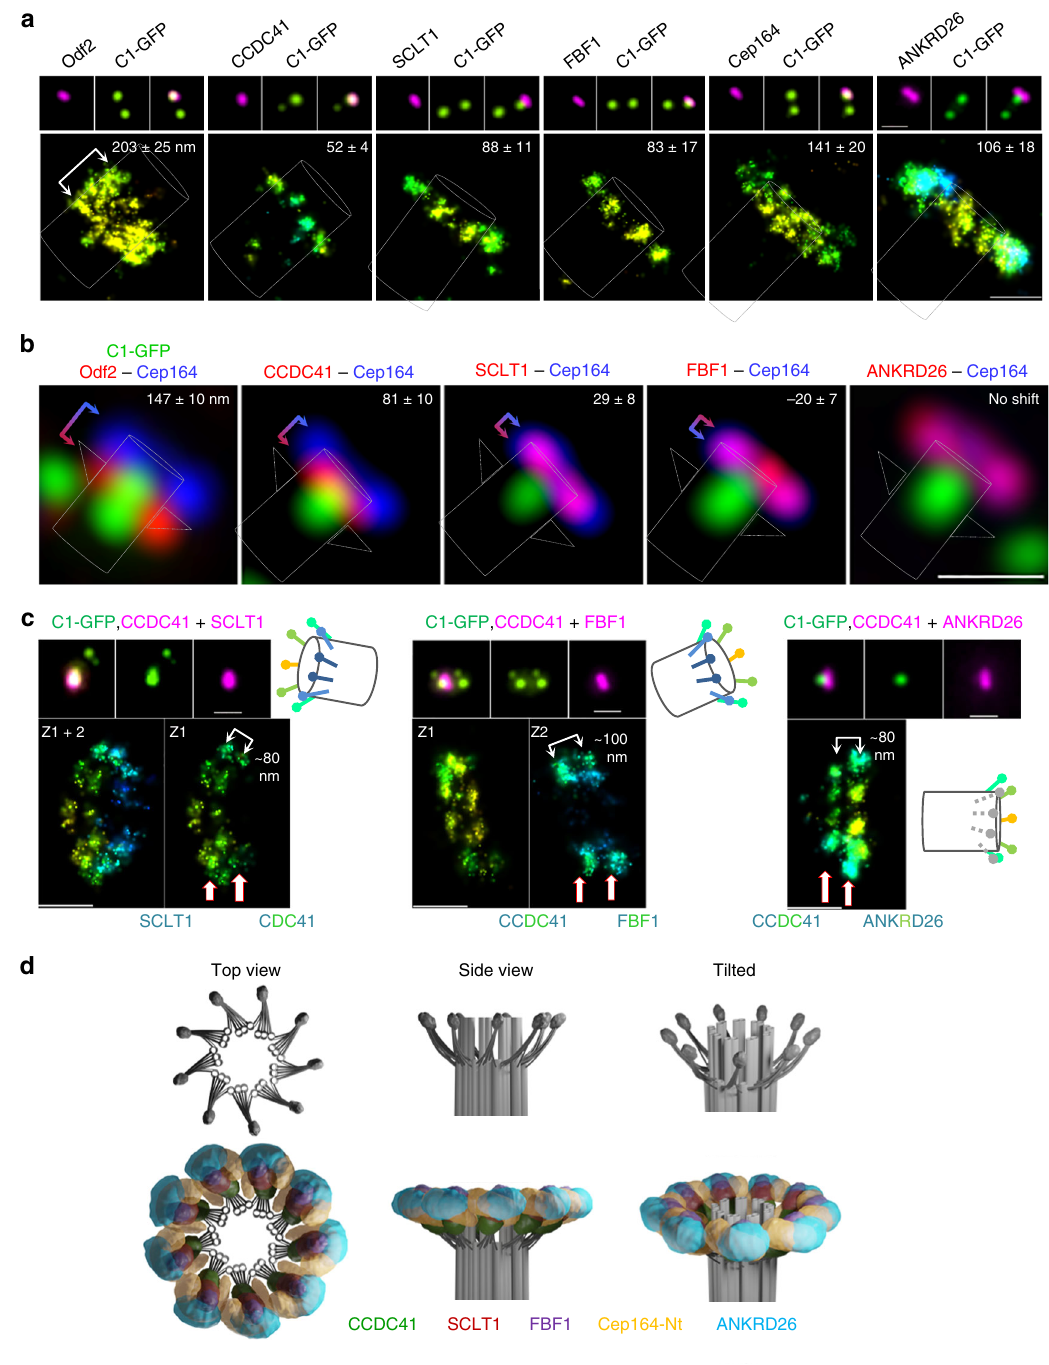
Fig. 4 Longitudinal distribution of distal appendage proteins. a A comparative wide- fi eld and 3D STORM analysis of the SDA component Odf2 and various DAPs on longitudinally-oriented older mother centrioles in interphase. The average ± s.d. thickness of the signals is noted. n = 11 centrioles for Odf2, 10 for CCDC41, 22 for SCLT1, 16 for FBF1, 26 for Cep164, and 10 for ANKRD26. b Two-color SIM images illustrating the lateral shift between the DAPs. The average ± s.d. distance between centers of each signal ’ s intensity peaks is indicated. CCDC41 signal localizes most distally, while SCLT1 almost colocalizes with Cep164. FBF1 signal appears slightly shifter towards the distal end. ANKRD26 and Cep164 colocalize. n = 8 centrioles for Odf2, 11 for CCDC41, 17 for SCLT1, 15 for FBF1 and 10 for ANKRD26. c Two-protein STORM analysis of longitudinally-oriented centrioles showing that CCDC41 and FBF1 are laterally shifted for ~100 nm, and CCDC41 and SCLT1 and CCDC41 and ANKRD26 for ~80 nm, corroborating values obtained in ( b ) by SIM. d A 3D model illustrating the organization of DAs electron densities, and the localization of the DAPs with respect to the electron densities. Scale bars: 1 μ m for all wide- fi eld images of centrioles and 200 nm for STORM